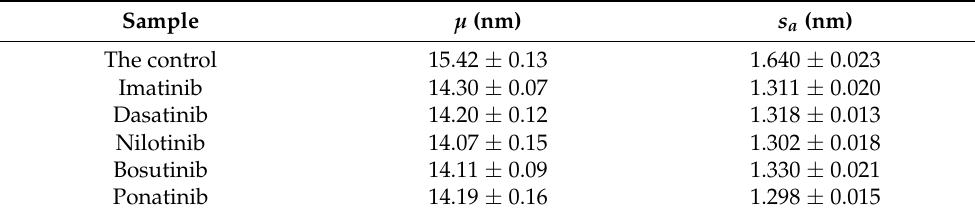
Table 2. Results for the average height ( µ ) and average roughness ( s a ) of the HSA layers in different solutions.